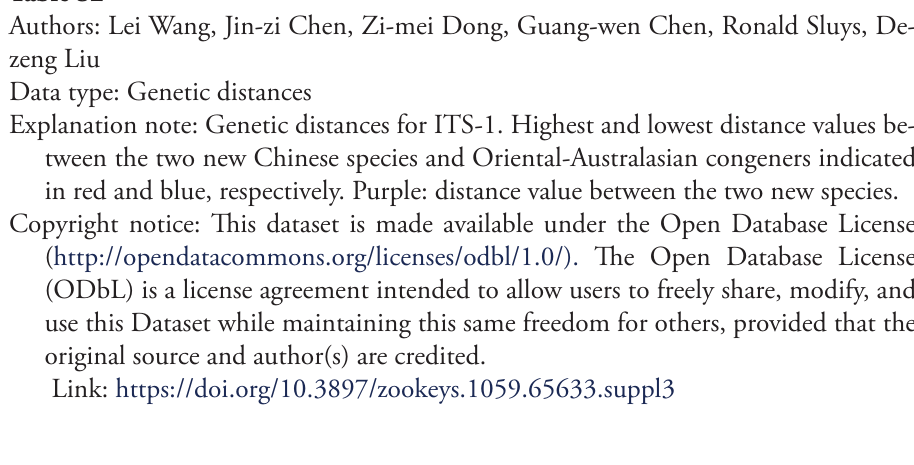
Data type: Genetic